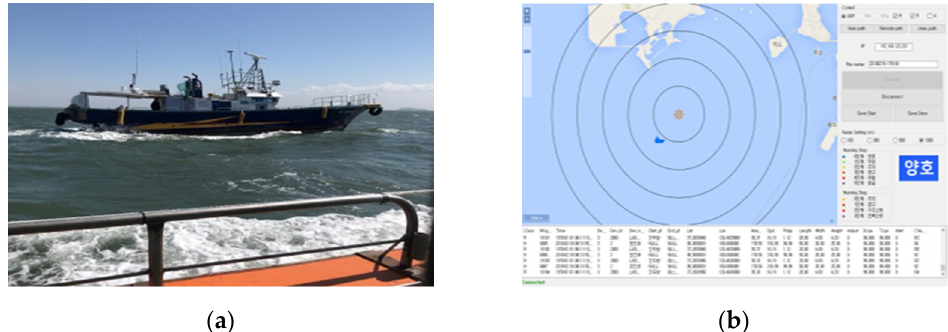
Figure 10. ( a ) Photo of approaching vessel at the time of the experiment; ( b ) system screen at the time of the experiment.